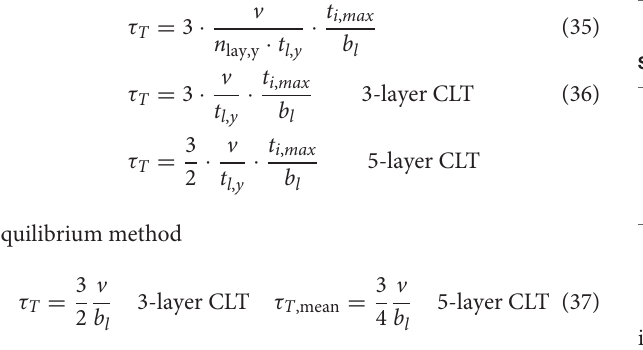
TABLE 4 | Stresses at failure, shear stresses calculated with the equilibrium